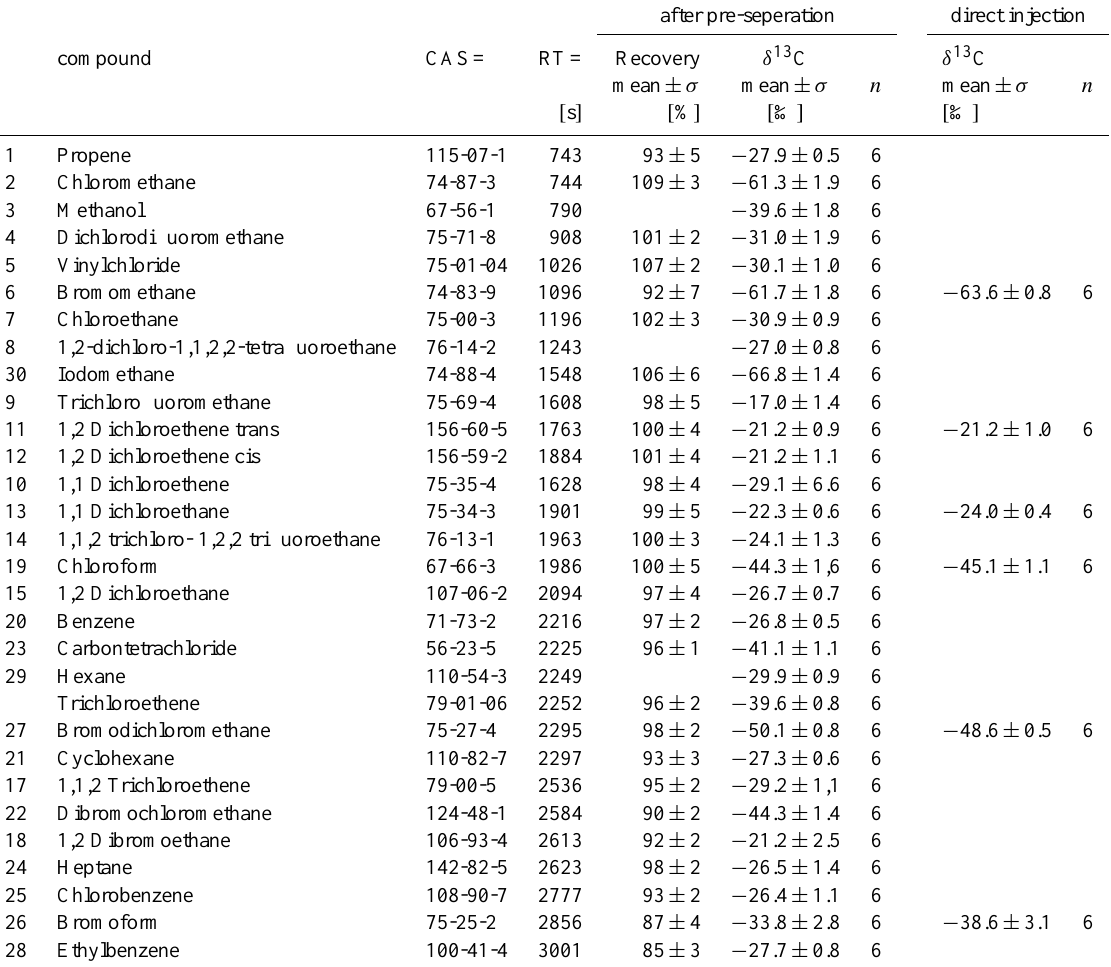
Table 1. Comparison of the carbon isotope ratios obtained with and without pre-separation for the Scott Speciality Gases TOC 15/17 standard and recovery rates for a sampling volume of 500l. Results are only given for compounds that were free of interferences from other